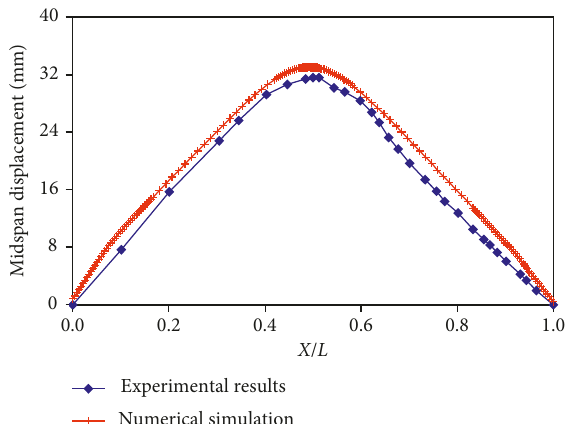
Figure 4: Comparison of the permanent deflected shape of the steel column 5C1 between the experimental test of Nassr et al. [4] and the present numerical